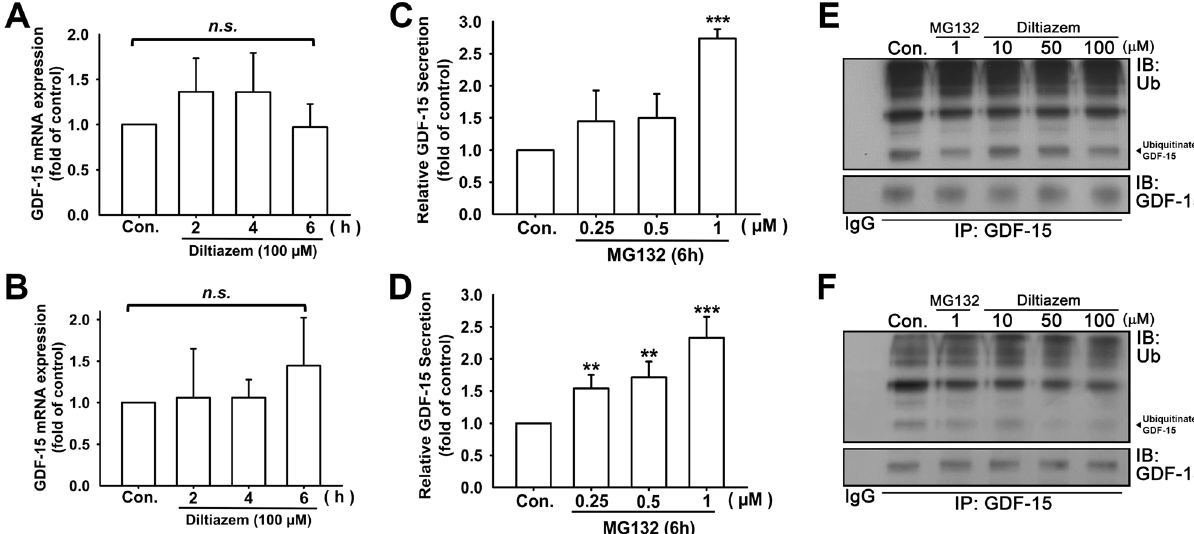
Fig. 5 Diltiazem decreases GDF-15 proteasomal degradation in breast cancer cell lines. After treating diltiazem for 2 to 6 h, the mRNA expression of GDF-15 had no signi fi cant changes on 4T1 cells ( A ) and MDA-MB-231 cells ( B ) analyzed by real-time PCR. In addition, treating cells with proteasome inhibitor MG132 (0.25 – 1 μ M) for 6 h markedly enhanced GDF-15 secretion in culture media on both 4T1 ( C ) and MDA- MB-231 cells ( D ) examined by ELISA. ( E , F ) The cell lysates were immunoprecipitated with normal IgG or anti-GDF-15 antibody. The immunoprecipitated proteins were subjected to SDS-PAGE and immunoblotted against ubiquitin (Ub) and GDF-15. Diltiazem dose- dependently decreased the level of ubiquitinated GDF-15, as well as MG132 did. Graphs showed mean ± S.D. of three independent